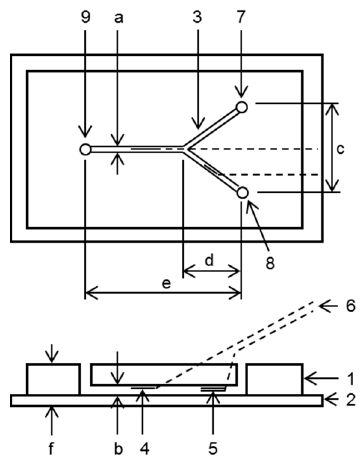
Figure 1. A schematic representation of the microfluidic pH measurement device made of polydimethylsiloxane (PDMS) and a glass slide. 1: pH measurement device body; 2: Glass slide; 3: Channel; 4: Measuring pH-FET (pH-FET m ); 5: Reference pH-FET (pH-FET r ) and pseudo-reference electrode; 6: Lead wires; 7: Sample solution inlet; 8: Baseline solution (BLS) inlet; 9: Outlet. Sizes (mm): a (1.0); b (0.5); c (17); d (12); e (32); f (6–8).